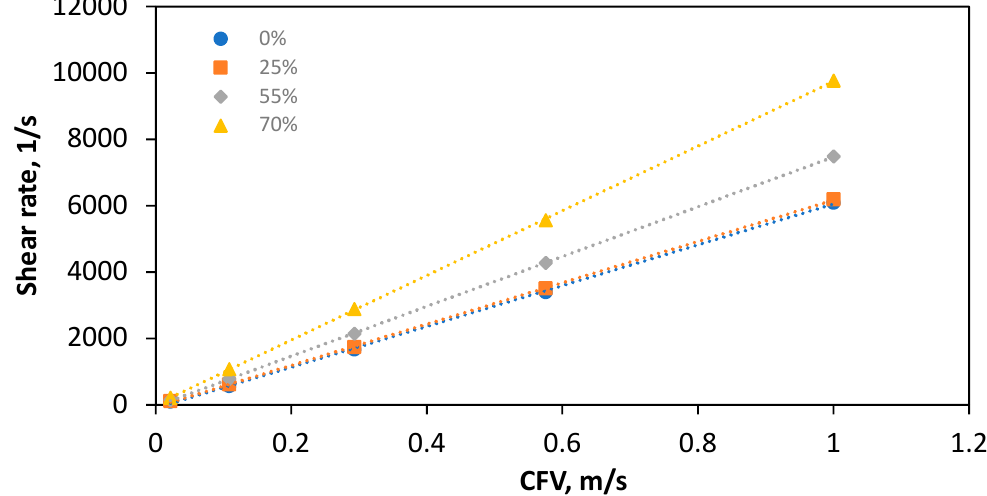
Figure 8. Interior average shear rate on the membrane surface between 0–70% occlusion by membrane displacement in draw channel.